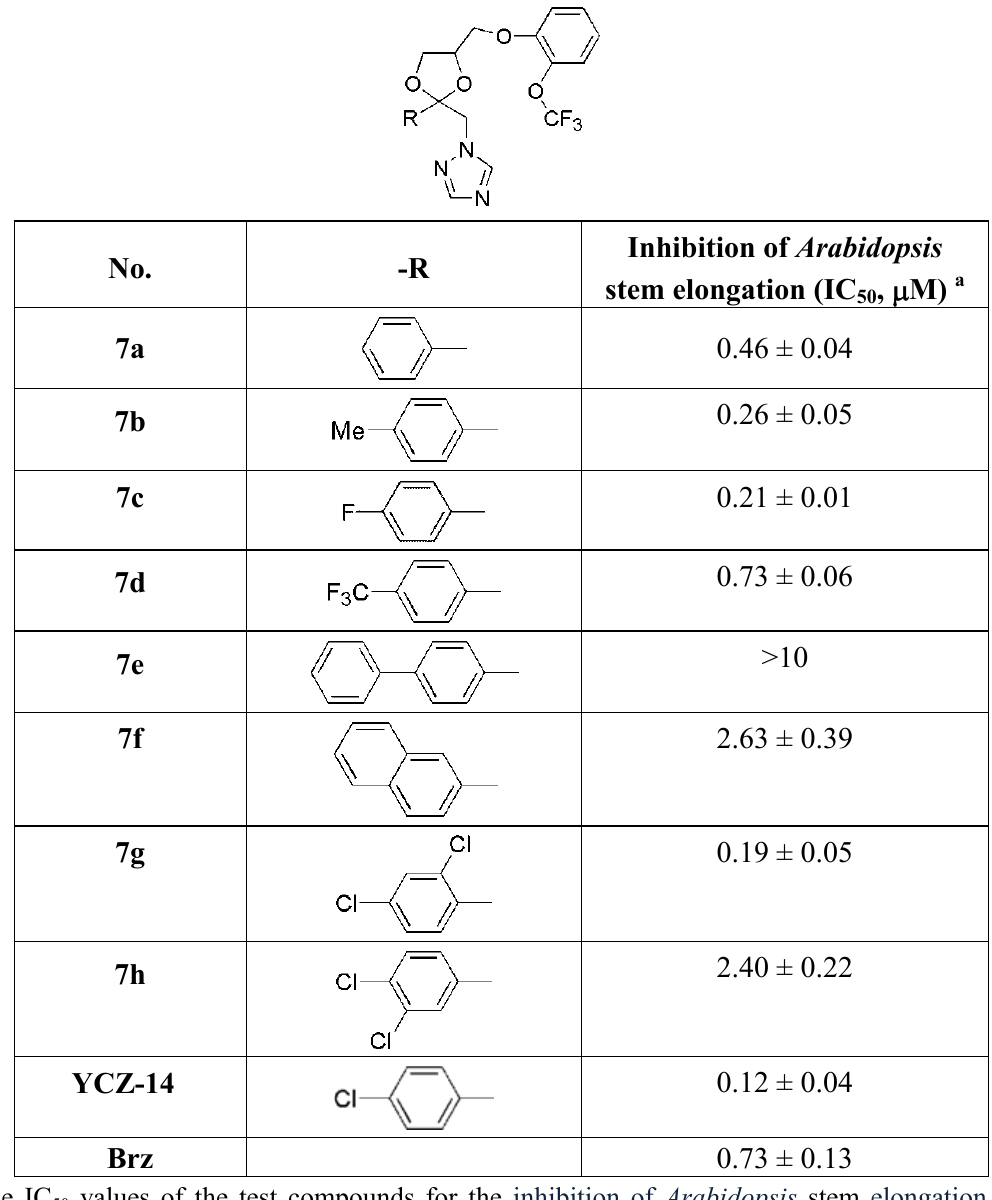
Table 1. Inhibitory activity of triazole derivatives on Arabidopsis seedling